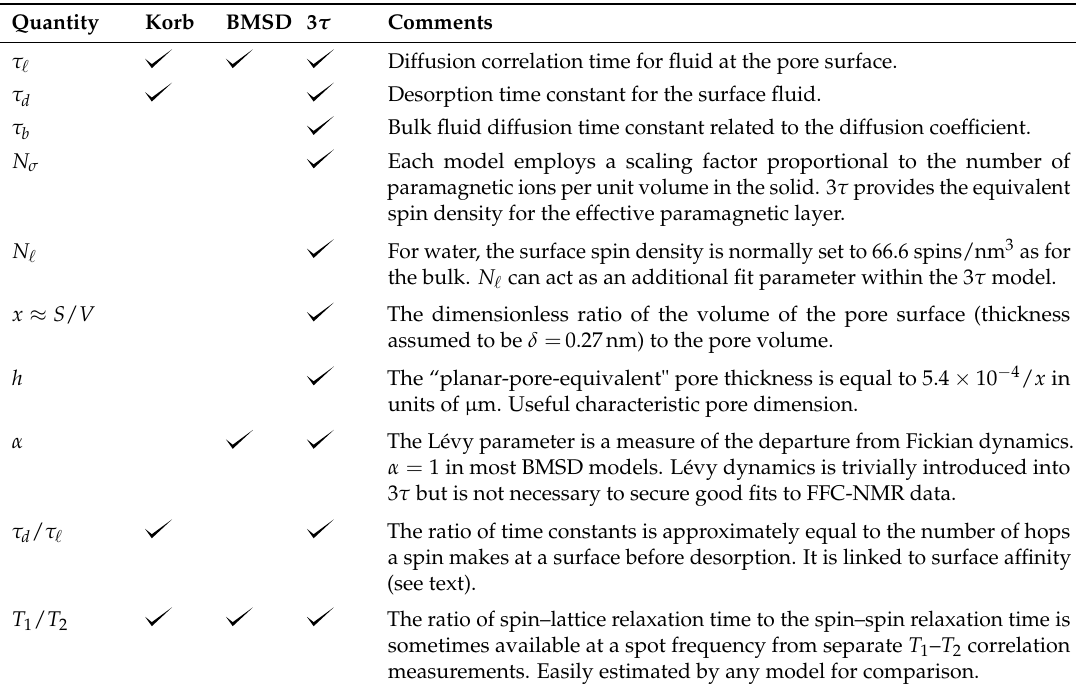
Figure 5. ( top ) The flow diagram provides a simplistic illustration of the function of the 3TM fitting package used to interpret FFC-NMR dispersion data. ( bottom ) A screen grab of the interface post-fitting is presented. Table 1. List of physical quantities that may be provided by an FFC-NMR measurement from a porous material by the Korb, bulk-mediated surface diffusion (BMSD) and 3 τ model